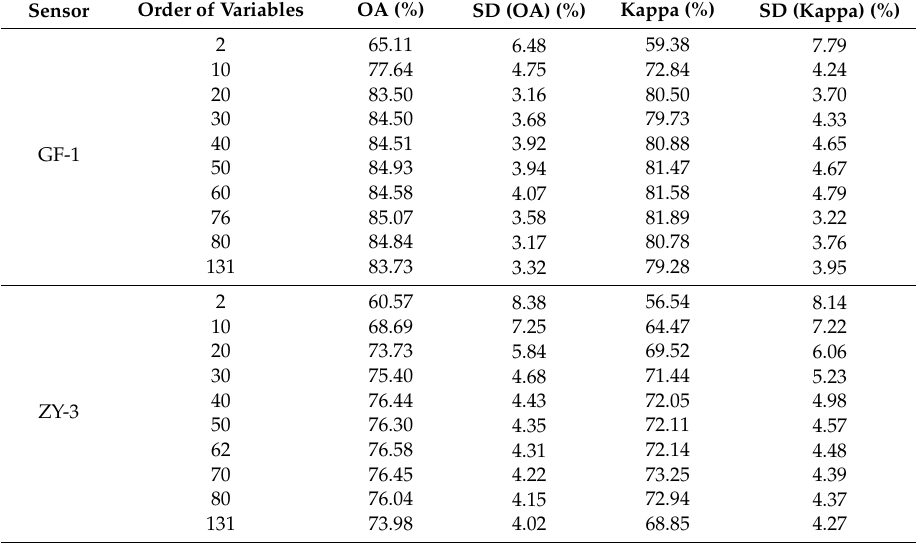
Figure 8. Input variables for scenario 4 using Boruta algorithm. ( a ) GF-1 data, ( b ) ZY-3 data. Table 8. Overall accuracy of trained RF model using Boruta-based variable selection. OA: overall accuracy; SD: standard